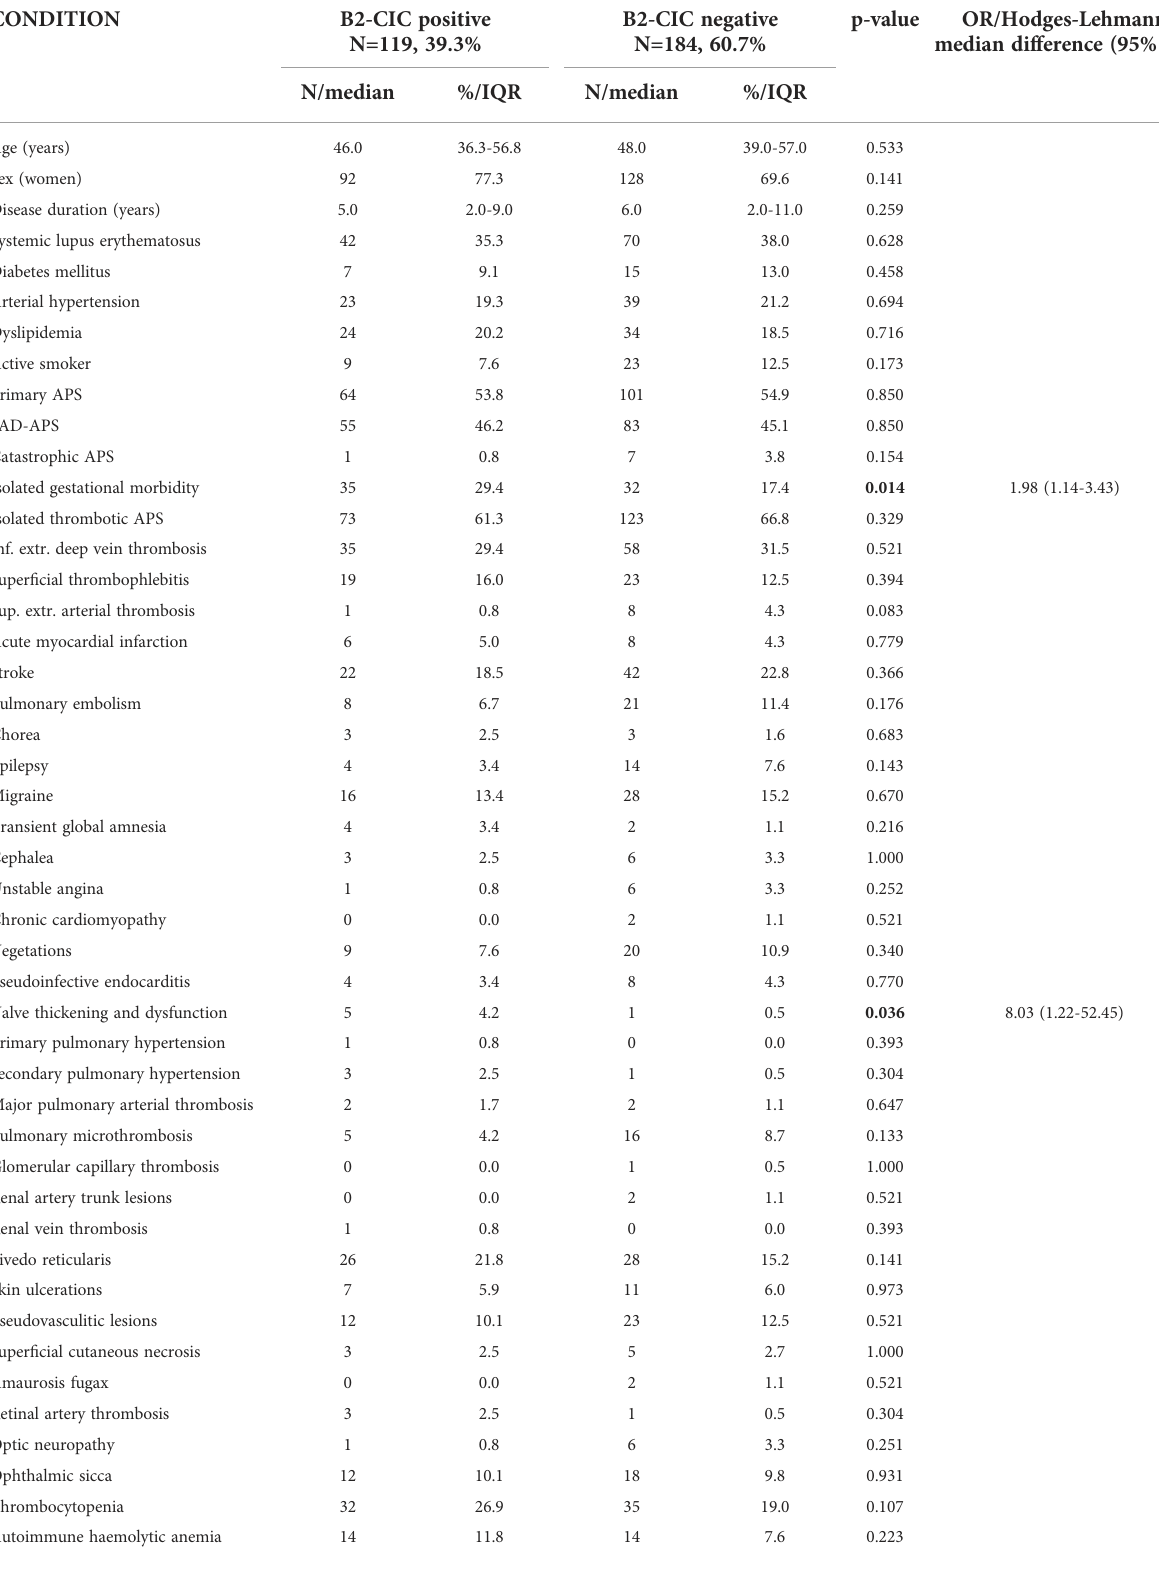
TABLE 2 Clinical, demographic and laboratory parameters of the 303 APS patients grouped according to the positivity for B2-CIC.